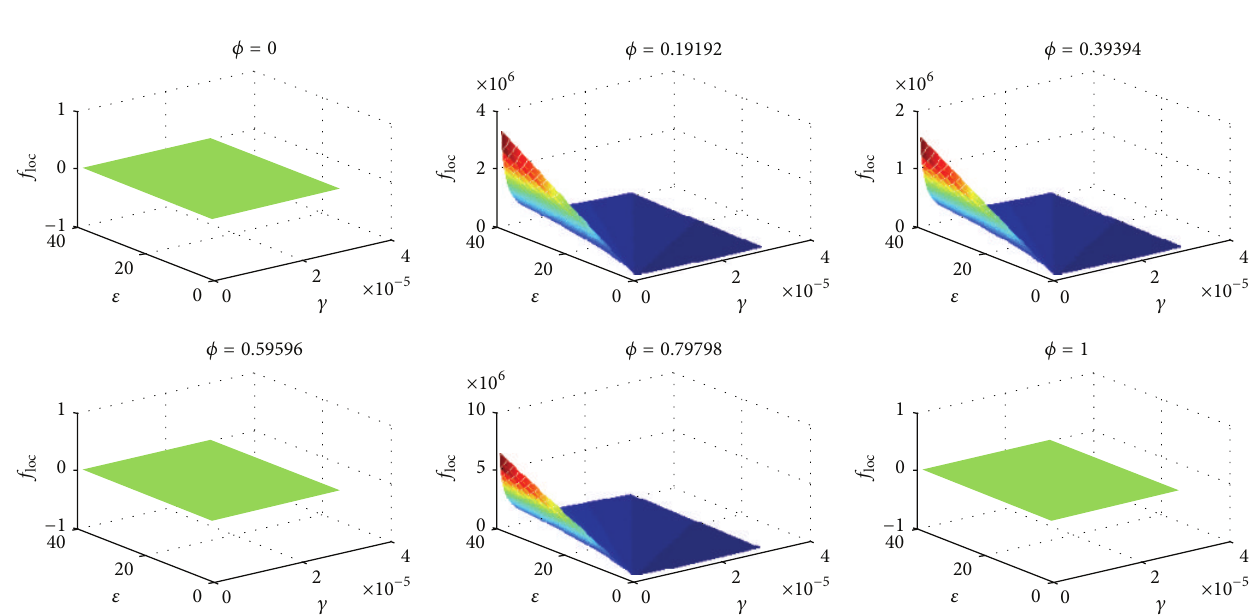
Figure 2: Local free energy density with respect to different 𝛾 .